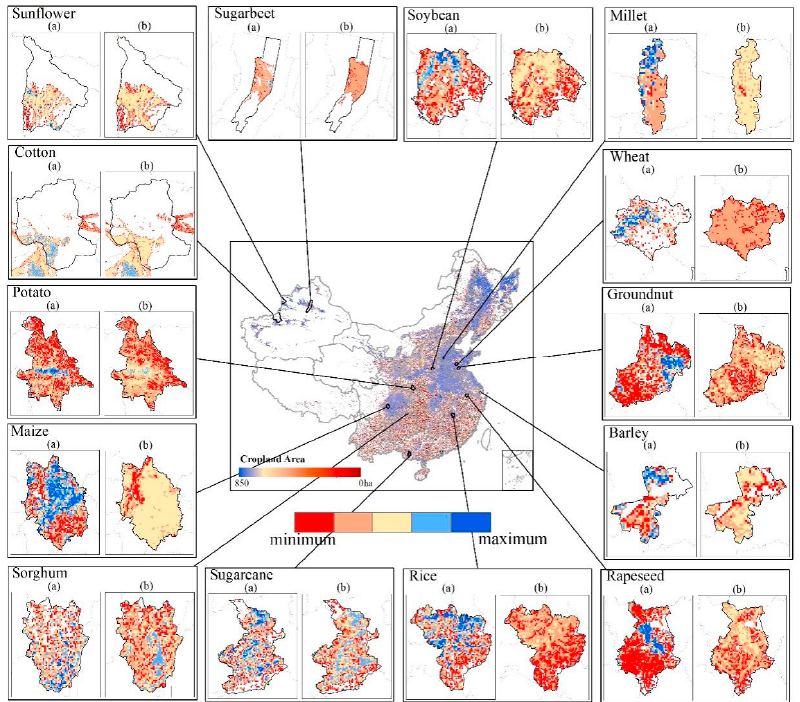
Figure 6. Comparison of the results from the allocation model based on cropping patterns ( a ) and the results from the average allocation model ( b ). Counties were randomly chosen from those with high harvest areas: wheat in Xintai County, the Huang-Huai-Hai region; soybean in Jincheng County, the Loess Plateau; rapeseed in Xuncheng County, the Yangtze River Middle and Lower Plain; potato in Ankang County, the southwest region; maize in Renshou County, the southwest region; rice in Fengcheng County, the Yangtze River Middle and Lower Plain; and sugarcane in Shule County, the Southern China